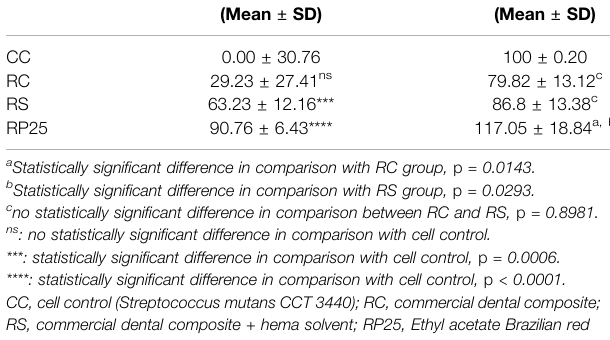
FIGURE 3 | Antibacterial ratio (r %) of EABRP enriched composite resin against S. mutans after 1h of direct contact test. CC, cell control; RC, commercial resin; RS, commercial resin + HEMA solvent. RP25, enriched EABRP composite resin at 0.25% (w/w). ***: p (cid:1) 0 .002 ****: p < 0.0001.